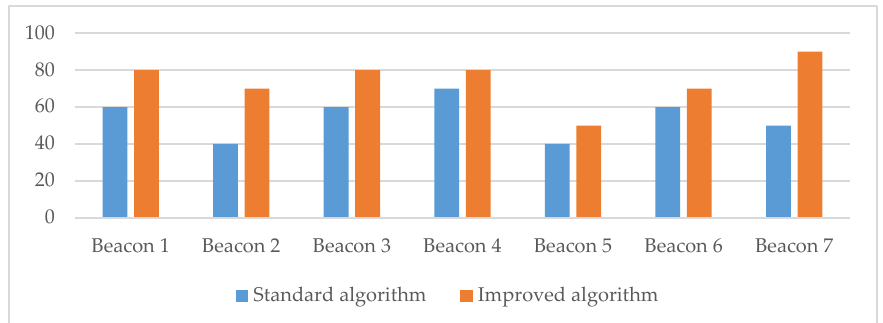
Figure 16. The success rate of correct transmitter detections for the controlled room environment with a high density of obstacles. Table 6. The success rate of correct transmitter detections for different environment settings (controlled room).